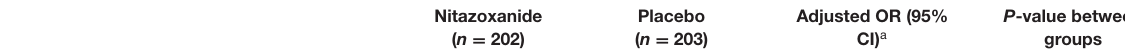
TABLE 2 | Primary and secondary outcomes in the mITT population. Outcomes Nitazoxanide Primary